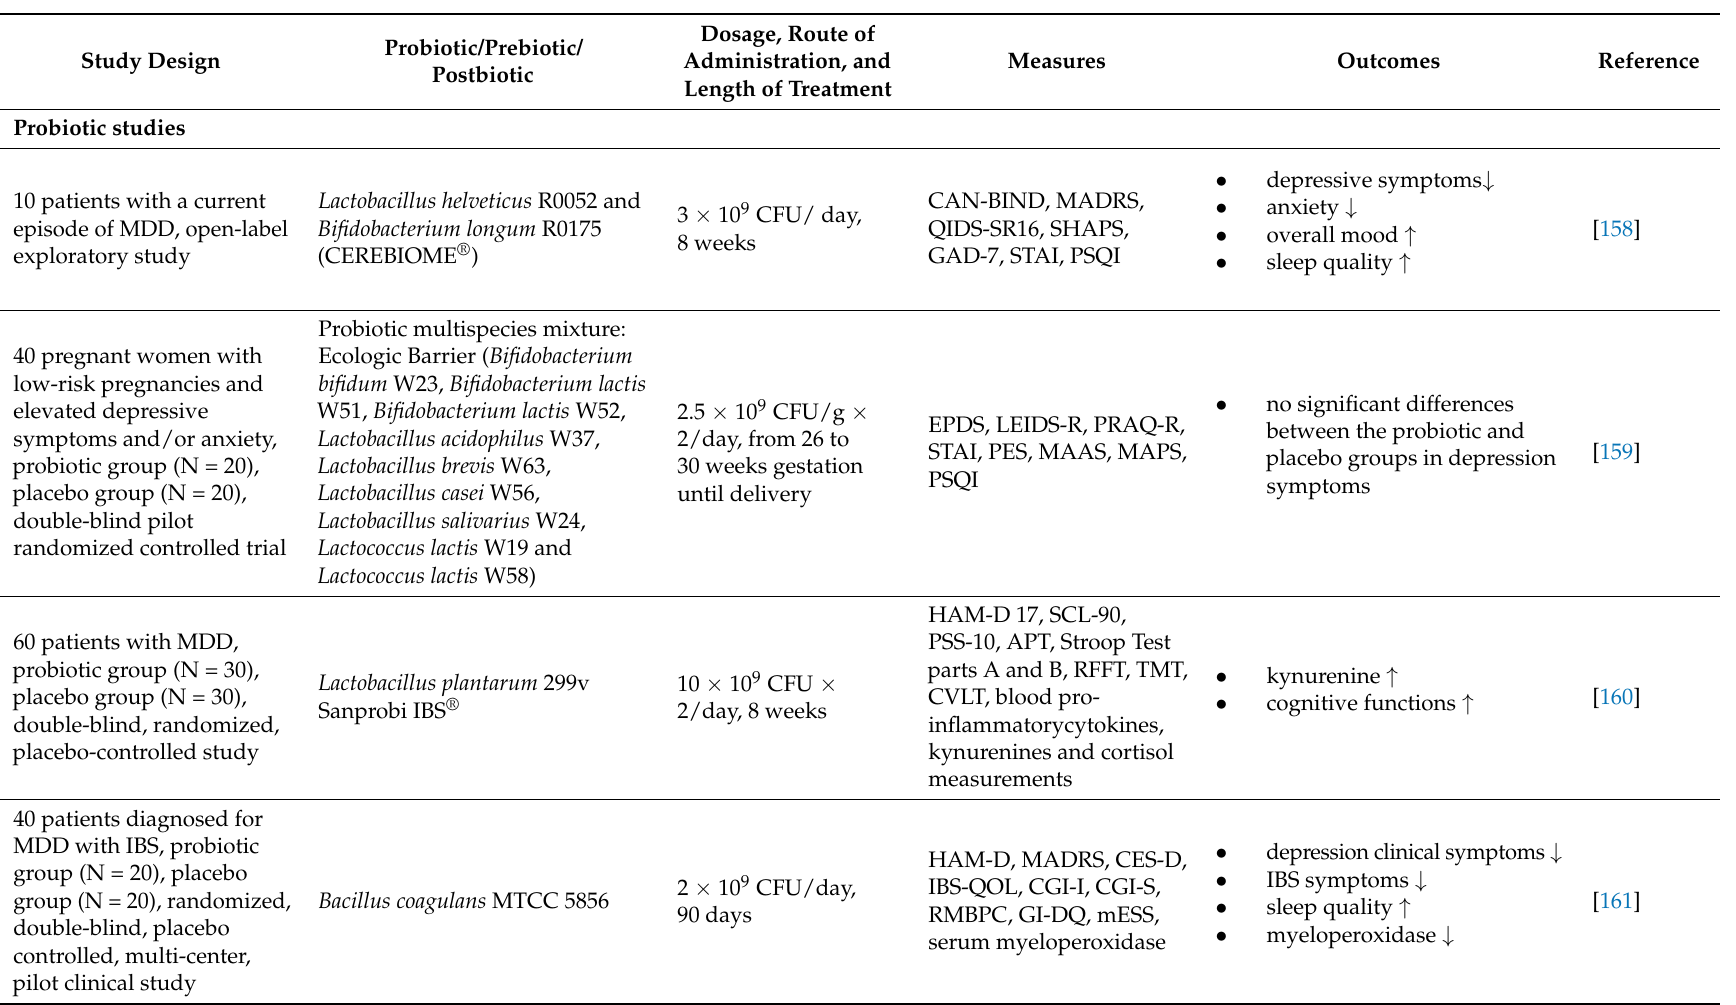
Table 3. Probiotic, prebiotics and postbiotics in human